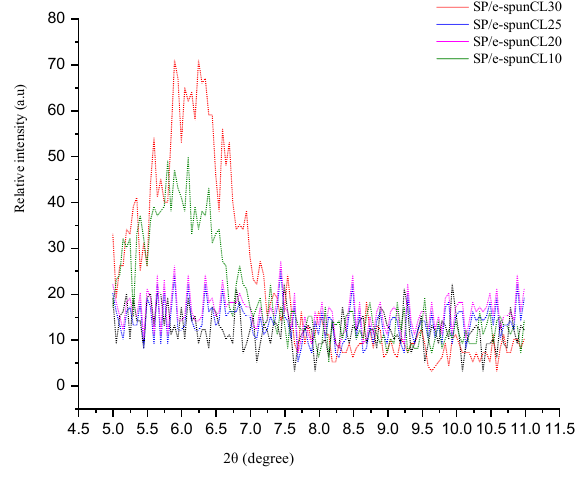
Figure 4. XRD of all SP/e-spunCL membranes.